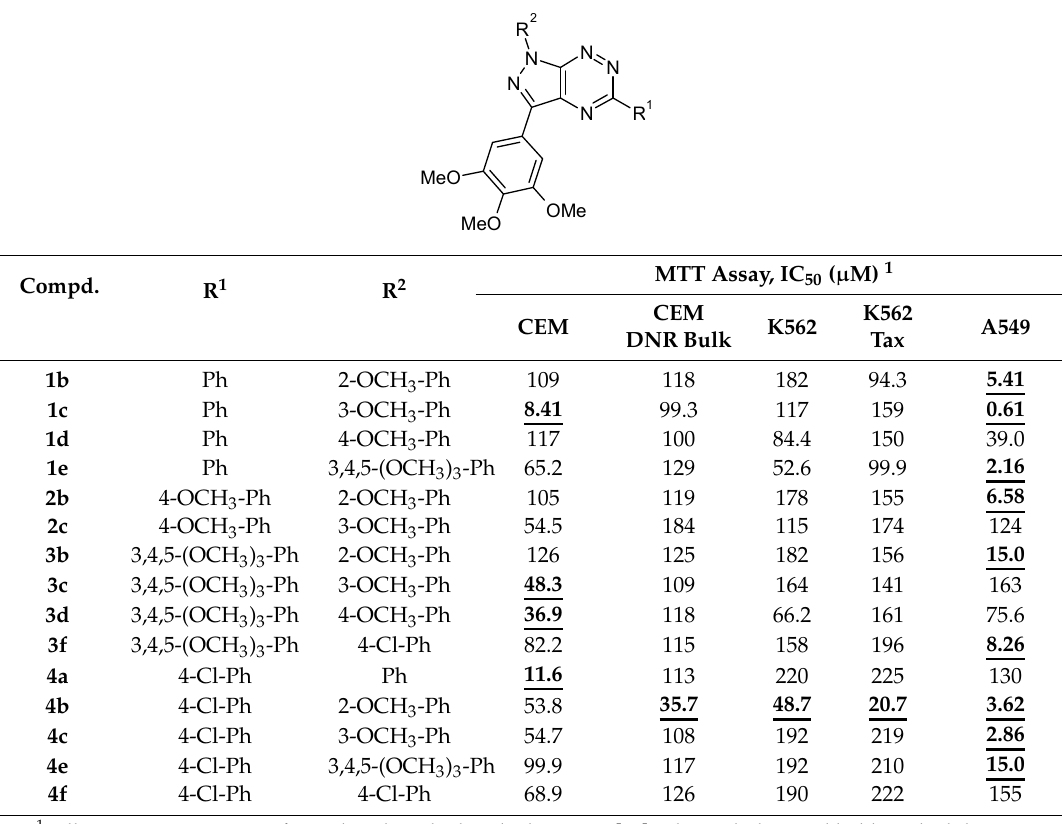
Molecules 2020 , 25 , x FOR PEER REVIEW Table 1. Cytotoxic activity of 1,5-diaryl-3-(3,4,5-trimethoxyphenyl)pyrazolo[4,3- e ][1,2,4]triazines.